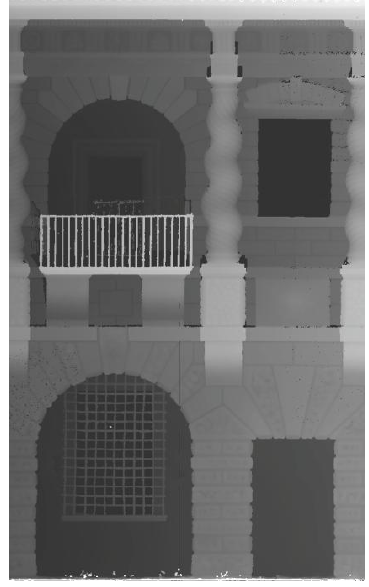
Figure 2. Height map of a part of the facade of Cortile della Cavallerizza in Palazzo Ducale in Mantova. The pixel coverage is about